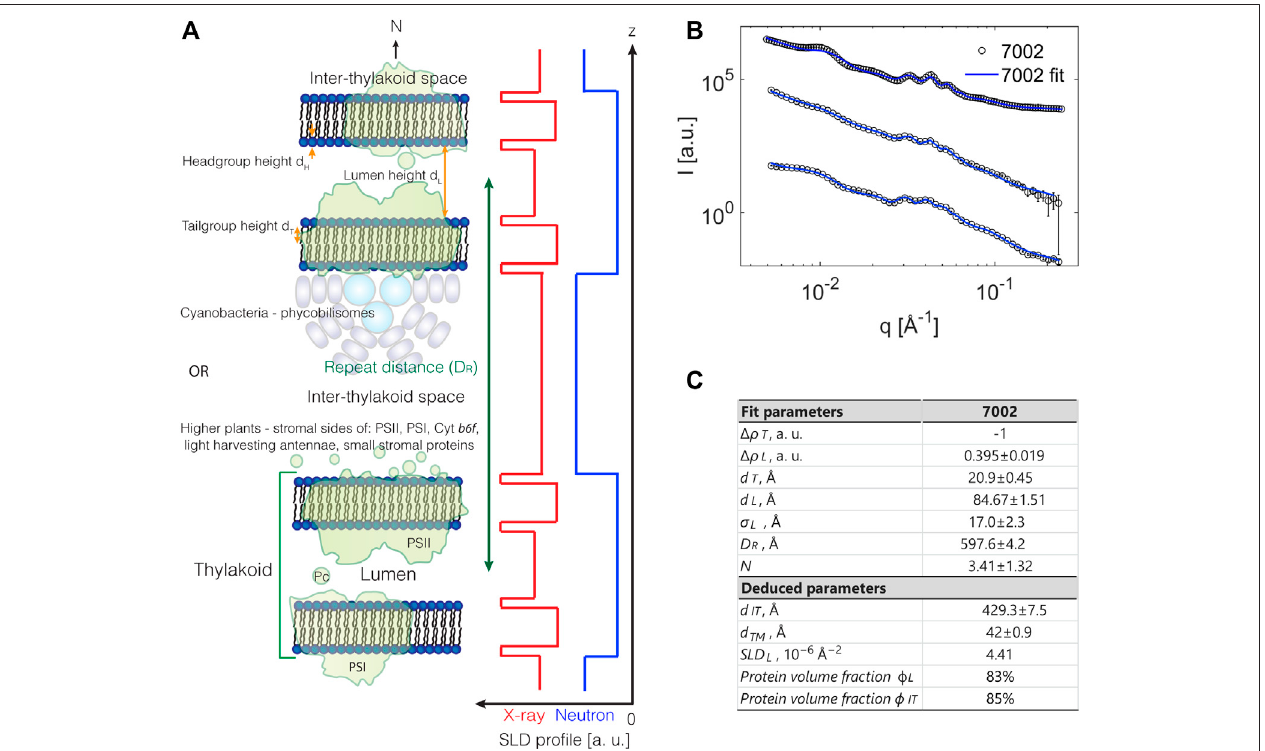
FIGURE 3 | (A) Illustration of structural model for a photosynthetic membrane system with a stack of double layered thylakoids. Neutron (light blue) and X-ray (red) SLD pro fi les are schematically depicted. (B) Full q -range model fi tsto SANS data from three independent replicas of Synechococcus sp. PCC 7002[from Jakubauskas et al. (2019)]. (C) Extracted structural numbers from fi ts in